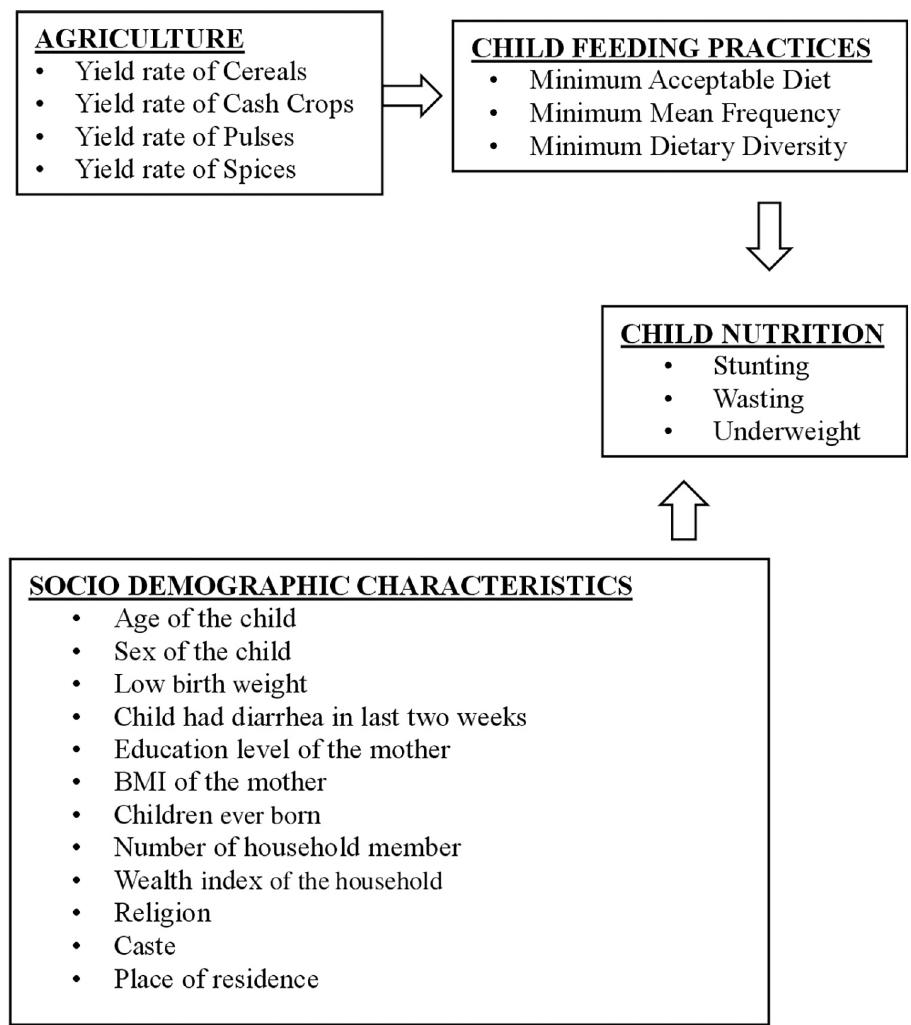
Fig 1. Conceptual